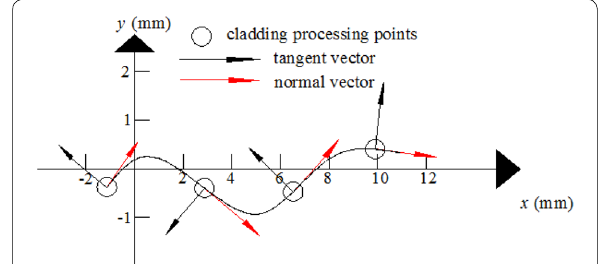
Figure 20 Determination of nozzle path